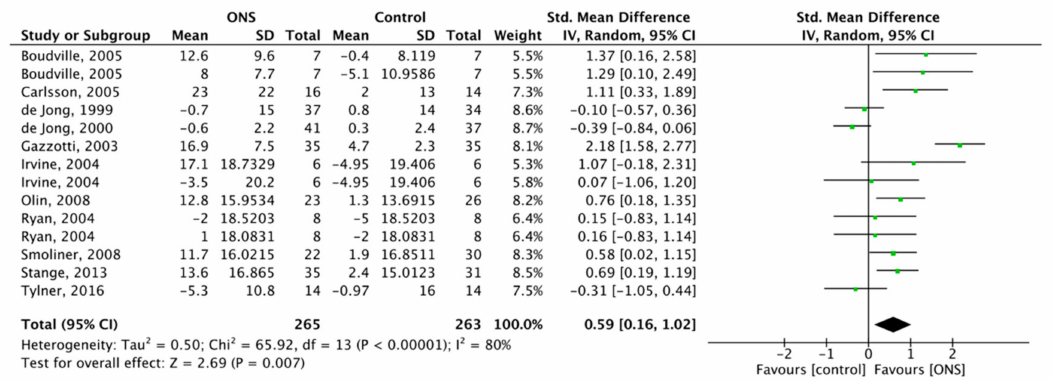
Figure 7. Forest plot comparing the effect of ONS on protein